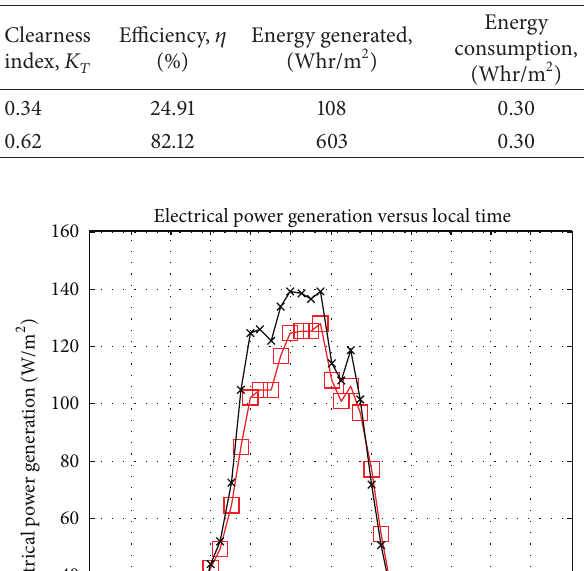
Figure 7: Electrical power generation in a sunny